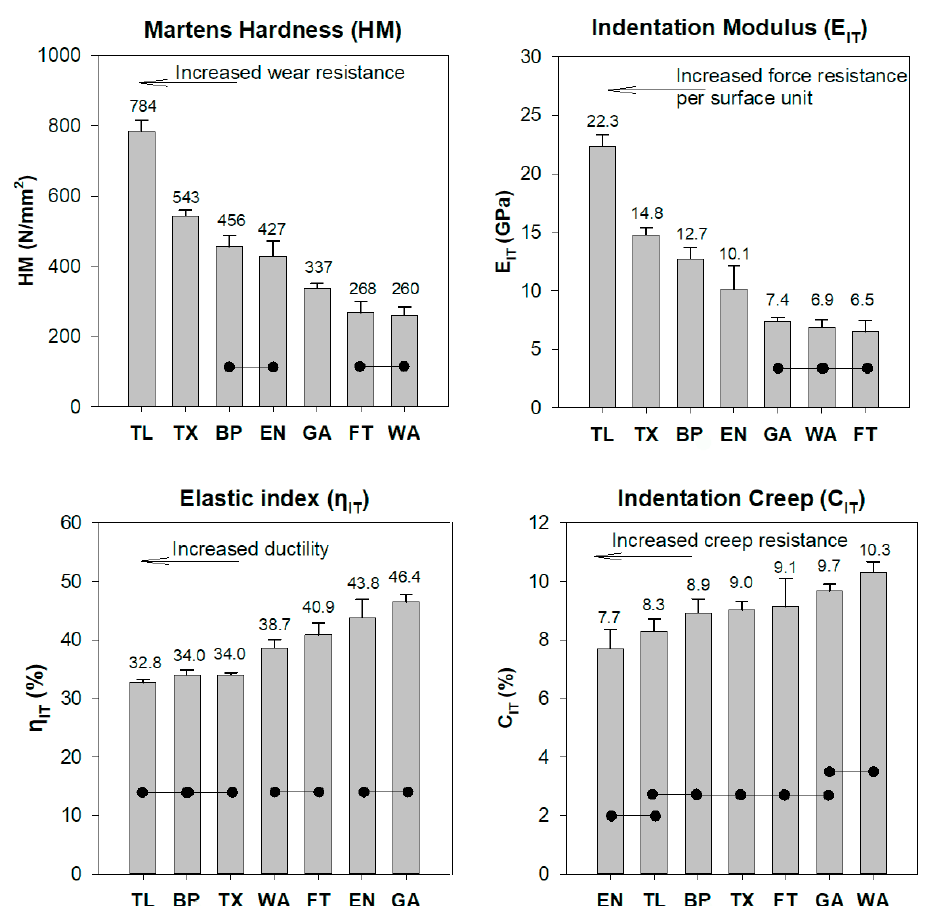
Figure 3. Mean values and standard deviations of all materials tested. Horizontal bars connect materials without statistical significant differences. The properties were sorted in ascending or descending order, starting from the left with the material with the best value for each property.